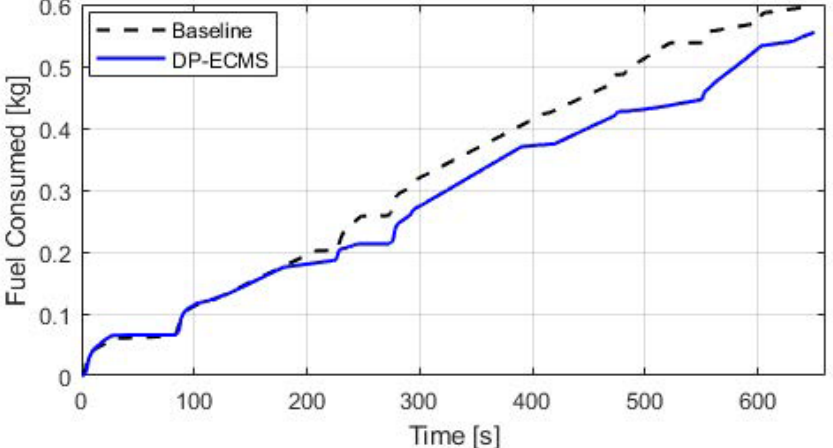
Figure 10. Fuel consumption comparison for DP-ECMS and baseline.